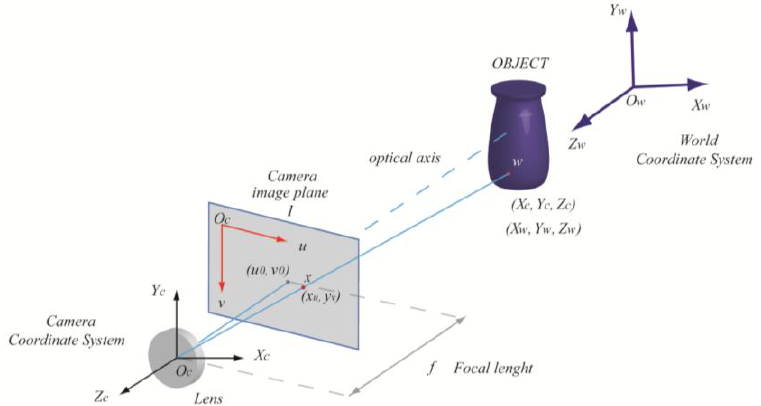
Figure 1. Pinhole camera model. The image point x = (x intersection of the optical ray going through the optical centre O distance equal to the focal length